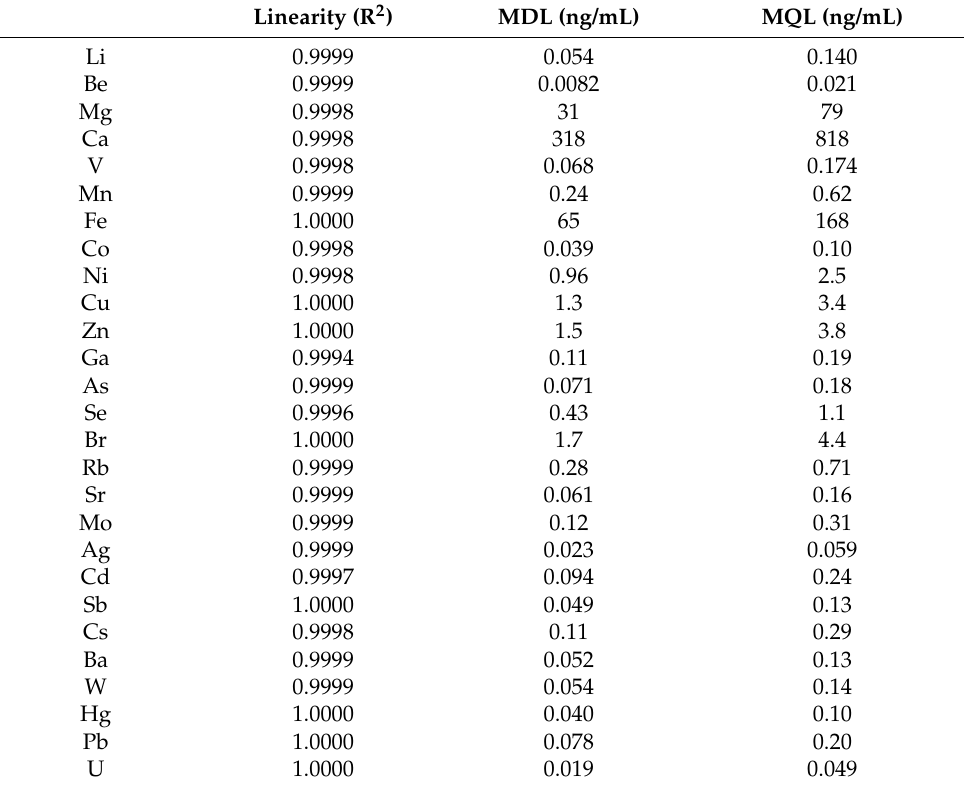
Table 2. Summary of method performance parameters.